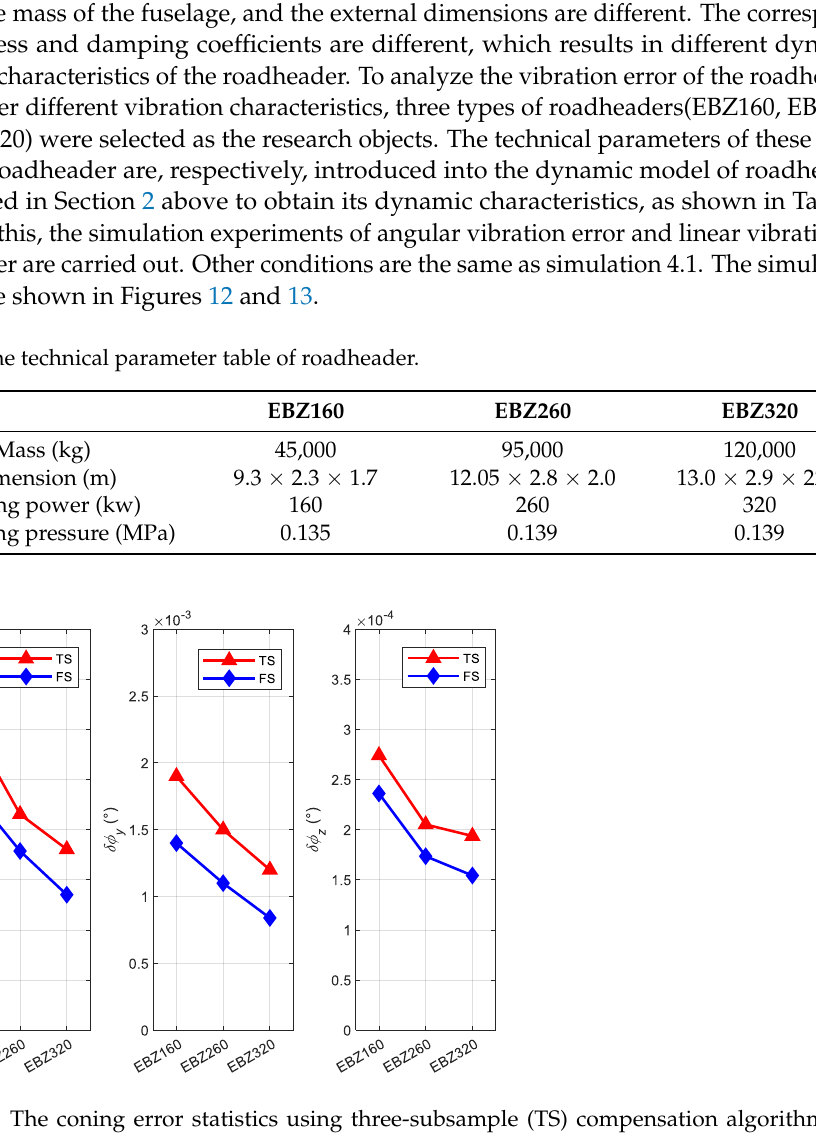
Figure 13. The sculling error statistics using three-subsample (TS) compensation algorithm and four-subsample (FS) compensation algorithm under different types of roadheaders. Table 4. The technical parameter table of roadheader. EBZ160